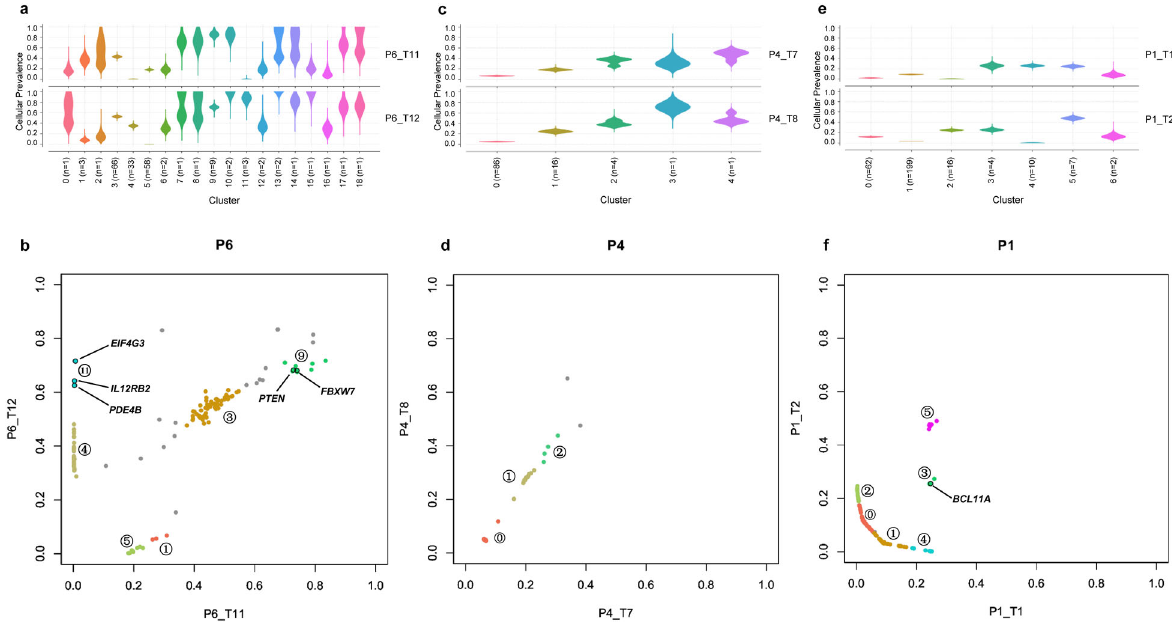
Fig. 3 Cancer cell fractions (CCFs) of subclones and mutations for patients P6, P4 and P1. We computed the CCF for each mutation found in the tumor samples from patients P6, P4, and P1. Hierarchical clustering of mutations is then performed to obtain putative subclones. a, c, e Subclone CCF density fi gure shown as violin plots. The x -axis represents subclone clusters, and the n value shows the number of mutations in each subclone. Each mutation has two CCF values (as they may be detected in both tumor samples). The y -axis represents the density of CCFs for each subclone. b, d, f Scatter plot of CCFs for each patient. Each point represents a mutation. The x - and y -axis represent the CCFs of a mutation for each of two tumor samples in a patient. Mutations belonging to clusters n ≥ 3 are shown in their corresponding cluster colors in the violin plot. Mutations belonging to clusters n < 3 are outliers (shown in light grey) and not clustered. a 19 PyClone inferred subclone clusters in P6. b CCF relationship for P6. Subclone 1, 3, 4, 5, 9, and 11 in a are marked. PTEN , FBXW7 , EIF4G3 , IL12RB2 , and PDE4B mutations are labelled with arrows.